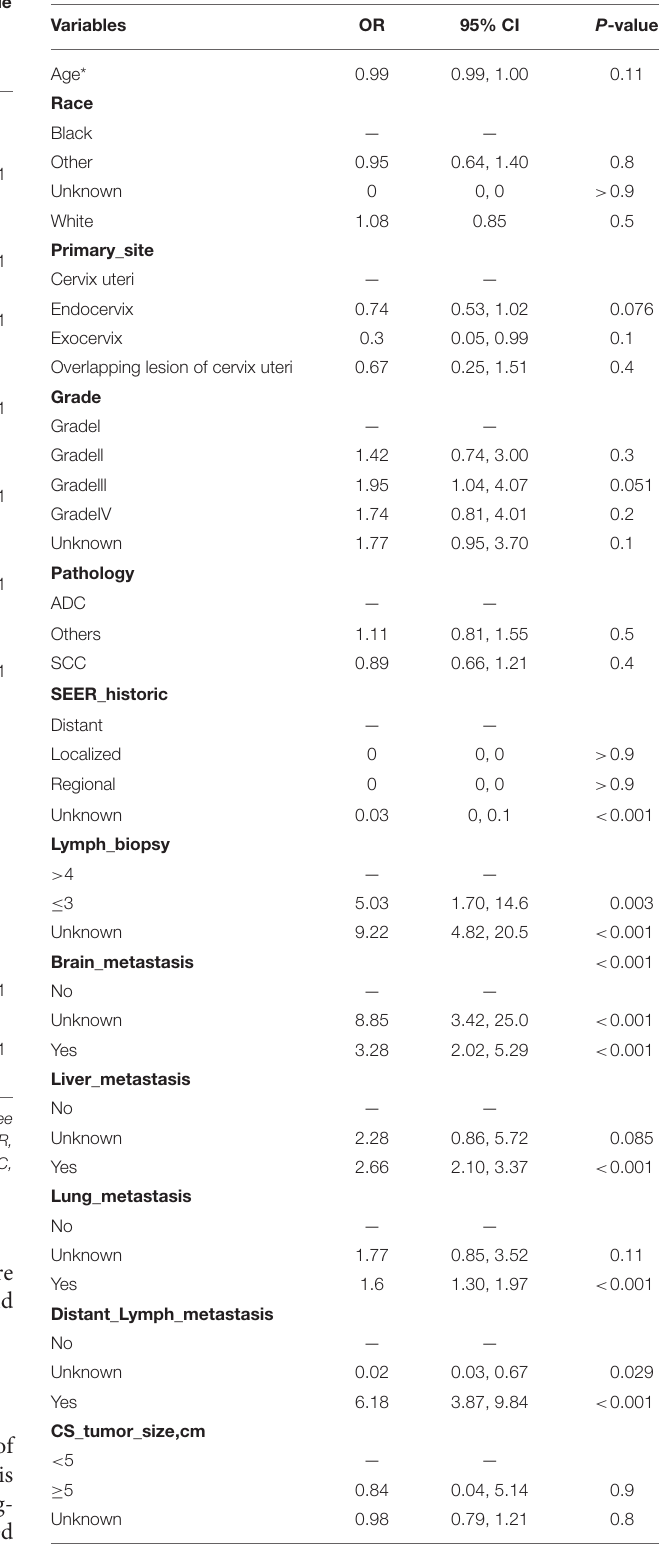
TABLE 2 | Multivariate logistic regression analysis for risk factors associated with bone metastasis in cervical